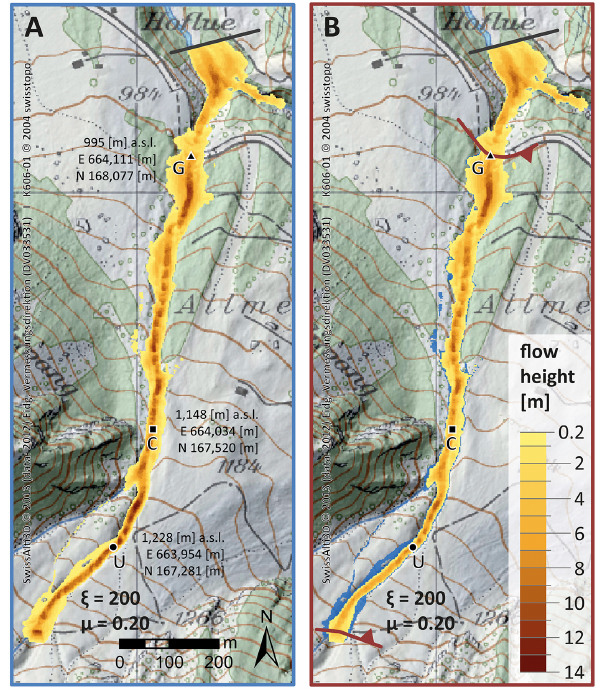
Figure 5. Maximum modeled flow height for the second event on 10 August 2010 (Table 1) using no-erosion modeling (a) compared to erosion modeling (b) , showing considerable differences in the extent of over-bank flow ( b : blue area). Locations U (upper fan, Inner Spreitgraben), C (below the confluence) and G (top of the road gallery) are used in Fig. 6.